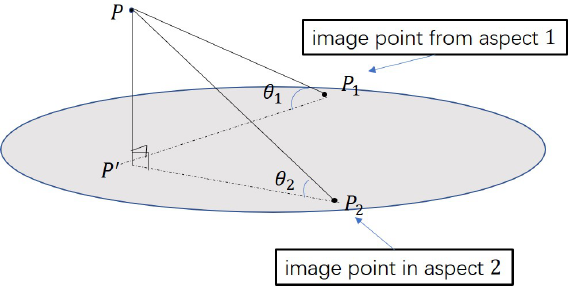
Figure 7. Schematic diagram of solution about plain coordinate